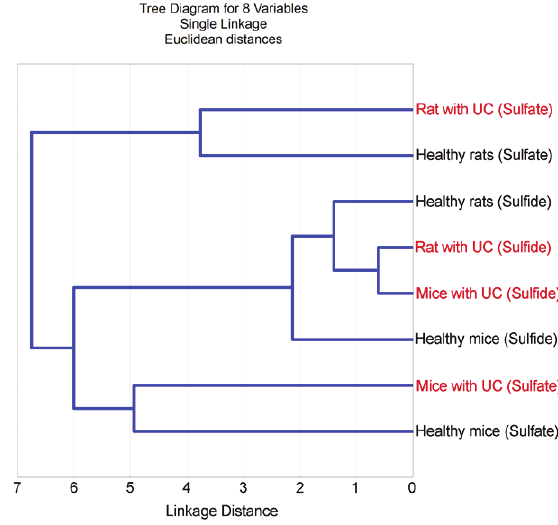
Figure 3: Cluster analysis of consuming sulfate and produced sulfide after 24